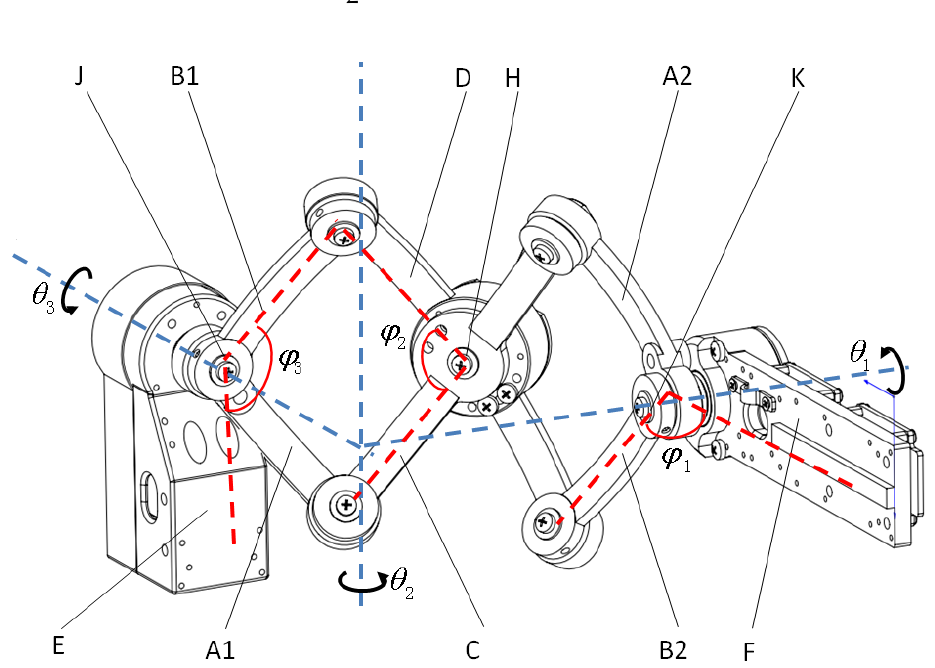
Figure 11. The mechanical structure of the spherical scissor exoskeleton shoulder.